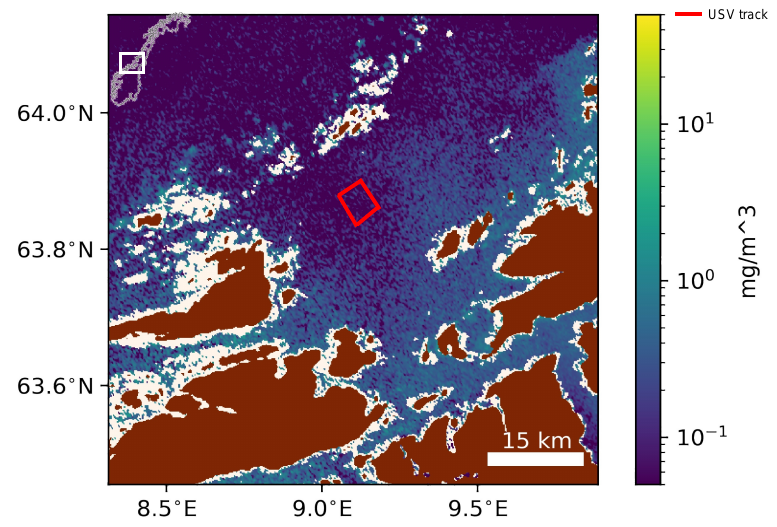
Figure 8. Sentinel-3 imagery of chlorophyll-a concentration in Frohavet (mid-Norway) on 14 March 2021. The AutoNaut track in Frohavet is shown in red. In the top left corner the location of Frohavet in Norway is